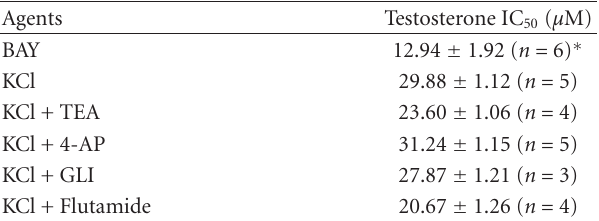
Table 1: IC 50 values ( μ M) of testosterone relaxant e ff ect on rat aortic rings contracted with BAY and with KCl (60mM) alone or in the presence of the following drugs: the K V channel blocker 4- aminopyridine (4-AP; 2 mM), the BK Ca channel blocker tetraethy- lammonium (TEA; 1 mM), the K ATP channel blocker glibenclamide (GLI; 10 μ M) and the testosterone receptor antagonists flutamide (10 μ M). Each value represents the mean ± SEM from the number of experiments shown in brackets. ∗ P < . 05 versus testosterone IC 50 obtained in KCl-contracted arteries, Student’s t -test.